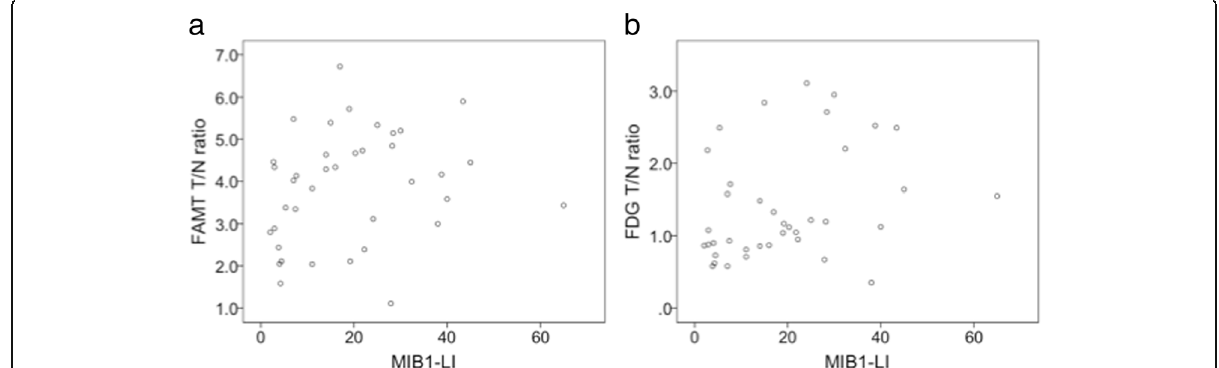
Fig. 3 Correlation analysis between the MIB-1 LI and the T/N ratio of 18 F-FAMT PET or 18 F-FDG PET. a The T/N ratio of 18 F-FAMT PET was not correlated with MIB-1 LI in all gliomas ( r s = 0.290, p = 0.077). b The T/N ratio of 18 F-FDG PET was positively correlated with MIB-1 LI in all gliomas ( r s = 0.400, p = 0.013)